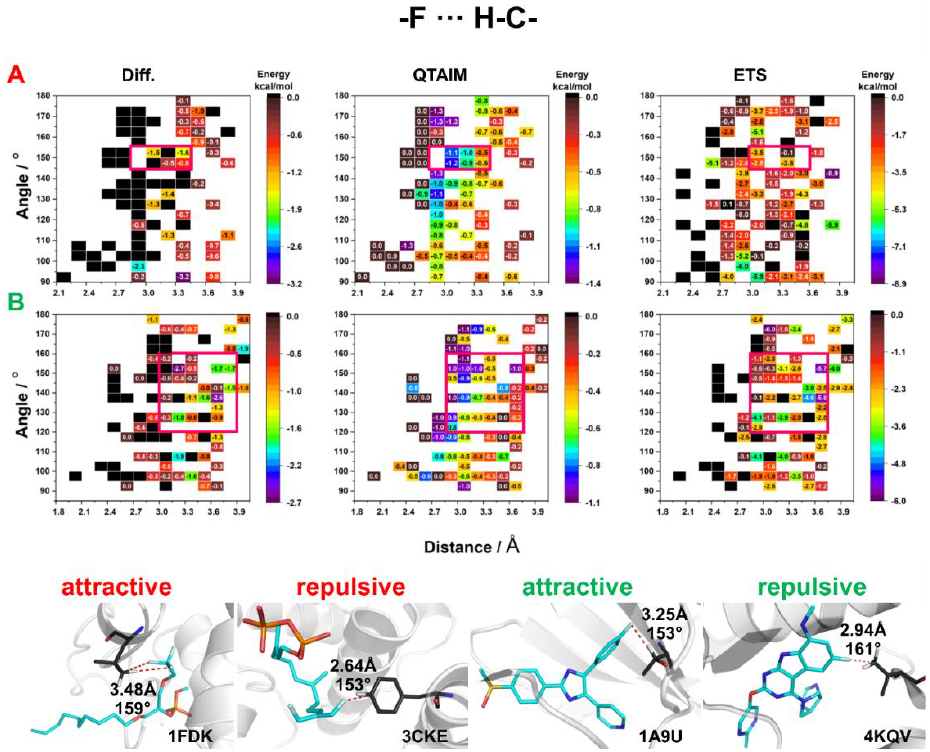
Figure 9. HB energy maps generated based on Diff, QTAIM, and ETS calculations of interaction energy between CH donor and fluorine attached to ( A ) an aliphatic fragment and ( B ) an aromatic ring for specific geometric parameters. The areas for which the highest stabilizing energy was observed in all three methods are marked with a red square.